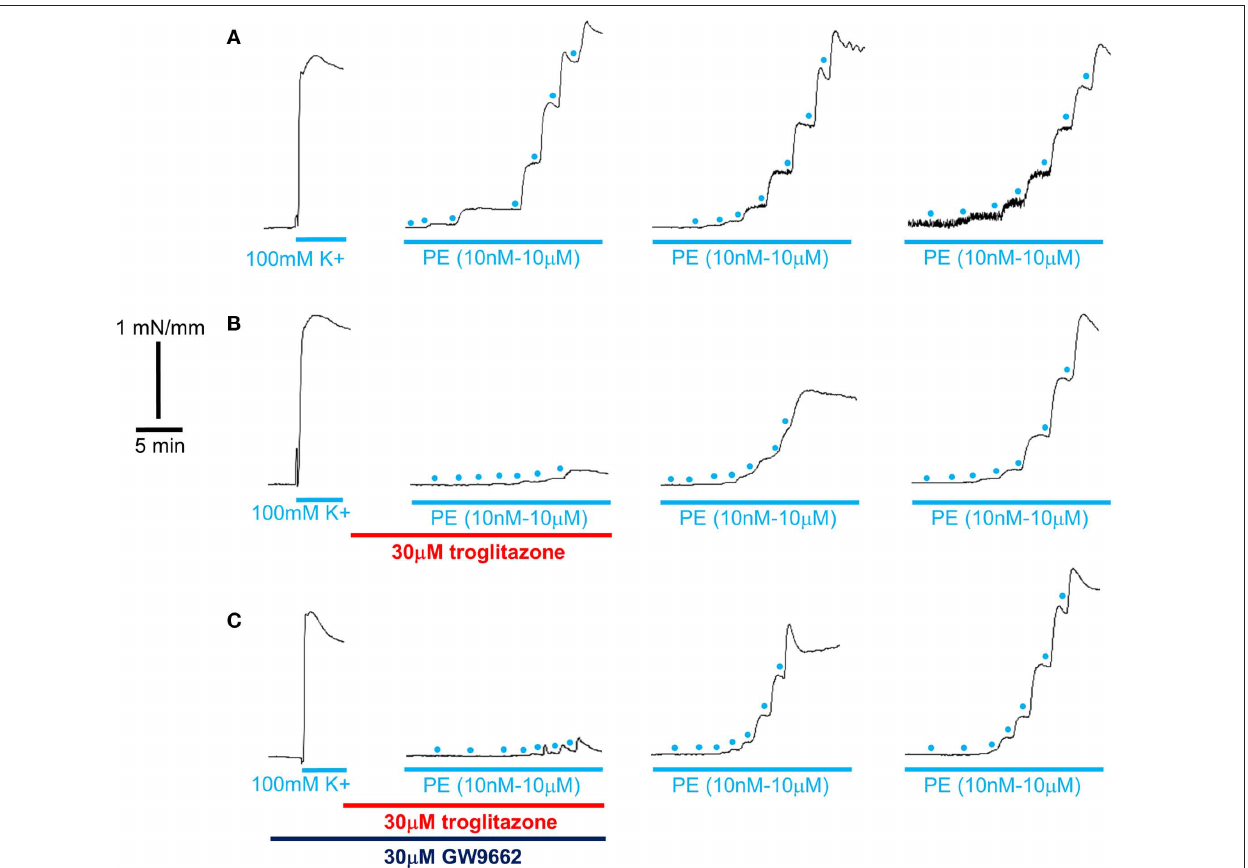
Figure 3 | effect of troglitazone on vasomotor responses to phenylephrine (Pe) in isolated femoral arteries. Arterial segments, mounted in a wire myograph, were first challenged with a 100-mM K + depolarizing solution, then with cumulative concentrations of PE (10 nM–10 μM), added to the organ chamber by half log increase, as indicated by dots on the tracing. Three consecutive runs of vasoconstriction to PE were carried out in each preparation,